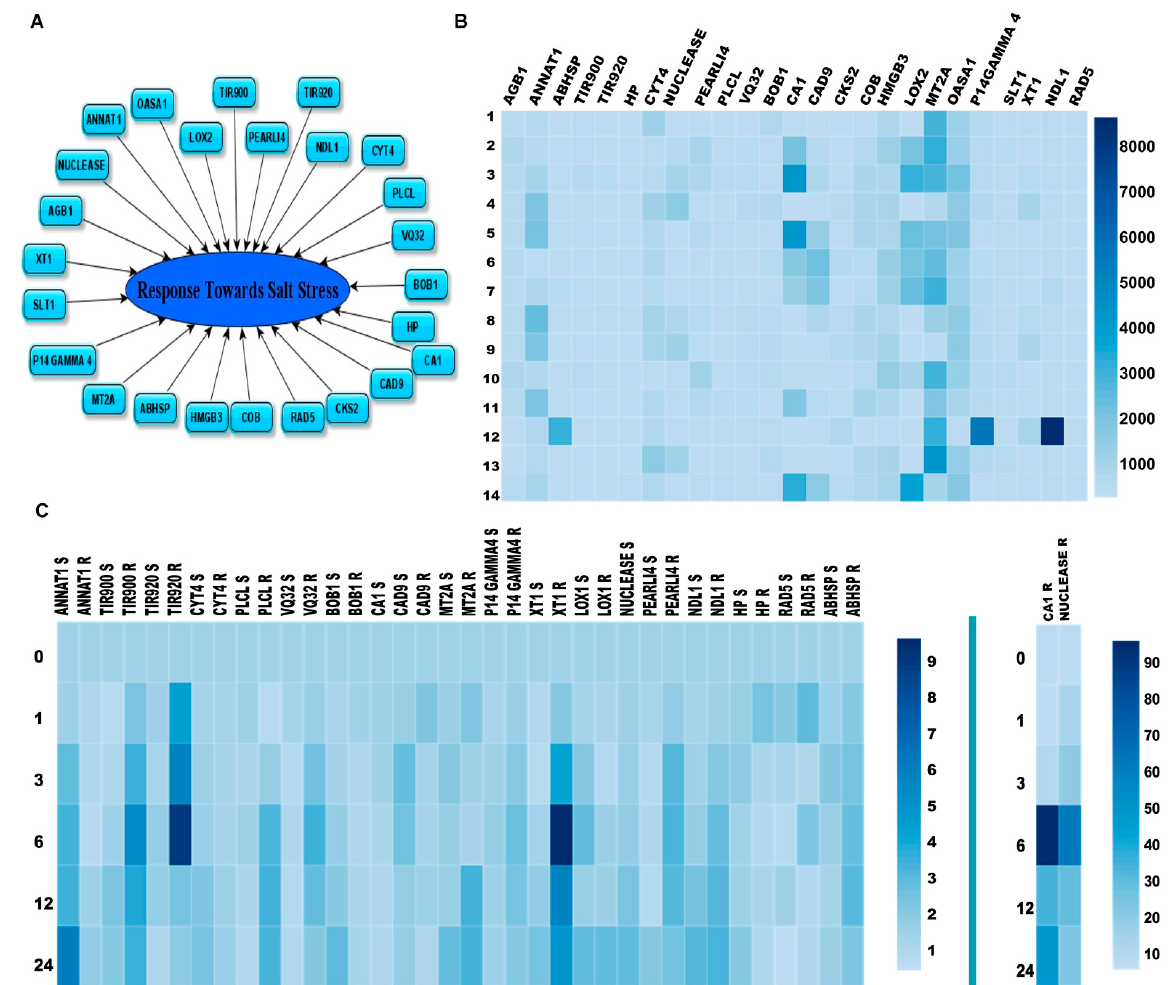
Figure 3. In-silico analysis of salt specific interactome of NDL1. ( A ) Putative interactors of NDL1 involved in salt stress responses from the interactome. ( B ) Heatmap showing in-silico expression analysis of 24 SRPIN by eFP browser (http://bar.utoronto.ca/efp2/Arabidopsis/Arabidopsis_eFPBrowser2.html, accessed on 20 March 2020) where the numbers are absolute expression values. The number on the left side of image represents; 1—Dry seed, 2—Cauline Leaf, 3—Cotyledon, 4—Root, 5—Entire Rosette After Transition to Flowering, 6—Flower Stage 9, 7—Flower Stage 15, 8—Hypocotyl, 9—Root, 10—Senescing Leaf, 11—Stem, 12—Mature Pollen, 13—Seeds Stage 10 w/o Siliques, 14—Vegetative Rosette. ( C ) In-silico microarray analysis heatmap showing expression of SRPIN in salt stress at different time intervals 0, 1, 3, 6, 12 and 24 h. Values obtained through ePF browser (Arabidopsis_eFPBrowser2.html, accessed on 20 March 2020) represent fold change in salt stress ( CA1 and NUCLEASE shown separately due to high range of expression values). Root and shoot in-silico microarray data of 15-day old seedlings of SRPIN after 150 mM NaCl treatment using eFP browser of TAIR (R and S added after gene names for expression in root and shoot